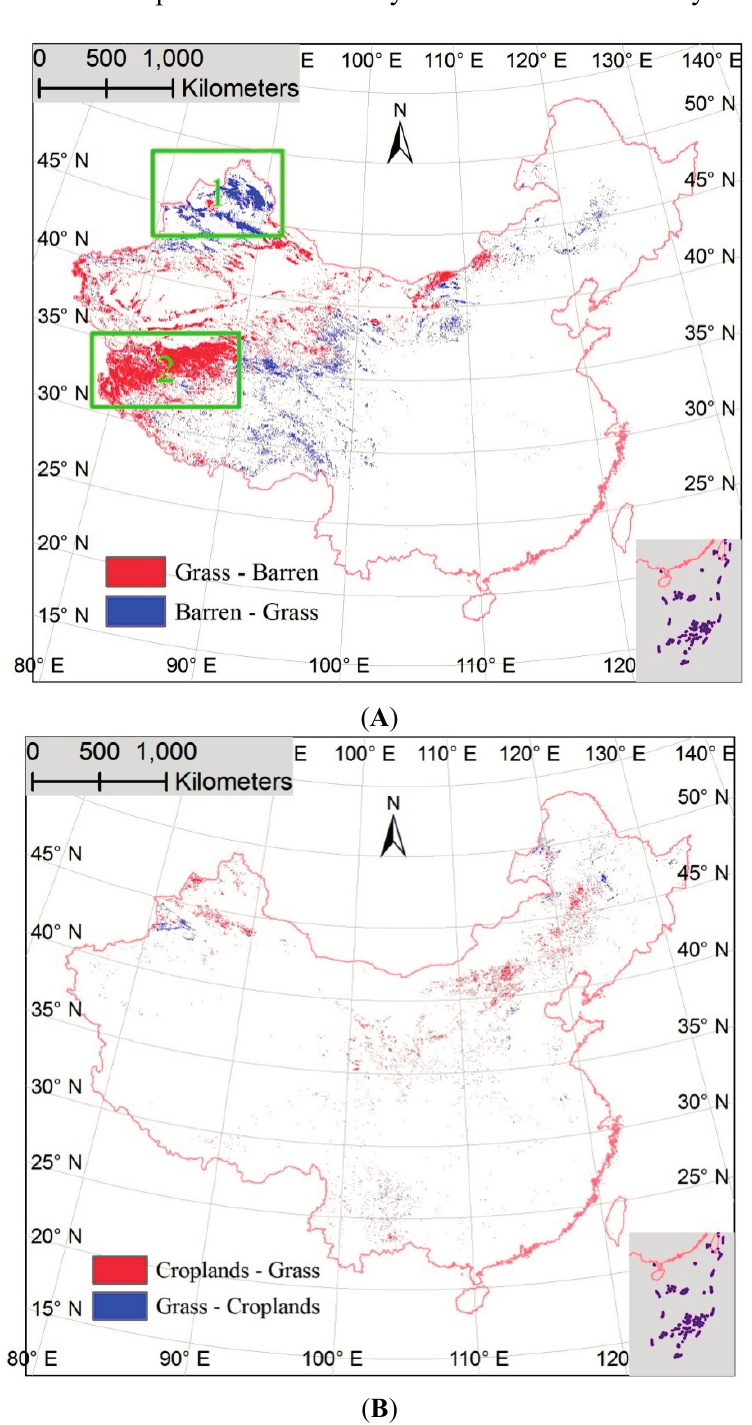
Figure 10. Distribution of misclassified pure pixels. As shown in the legends, the land cover type before “-” stands for the class in the reference data, and the land cover type after “-” stands for the class in the classification data. ( A ) Misclassification between grassland and barren land. ( B ) Misclassification between croplands and